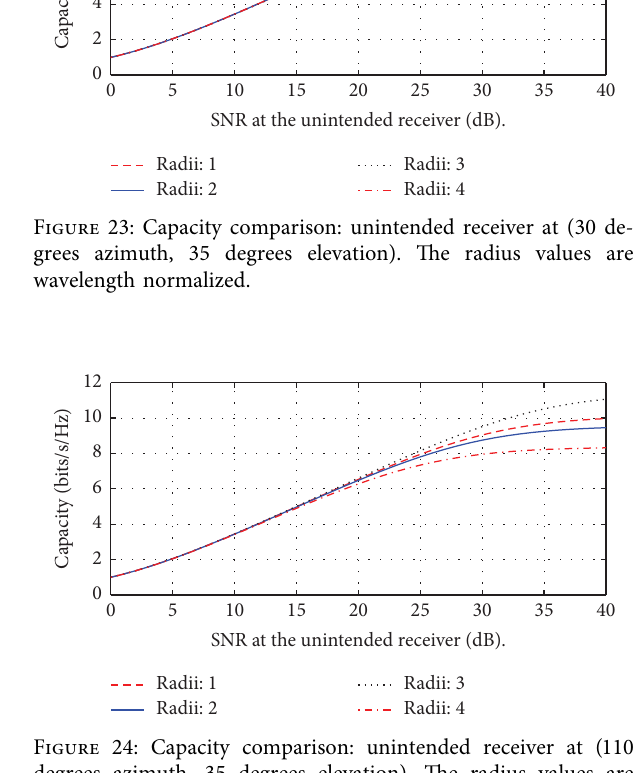
Figure 21: Average normalized power in the desired and undesired directions against cluster radius (wavelength normalized).